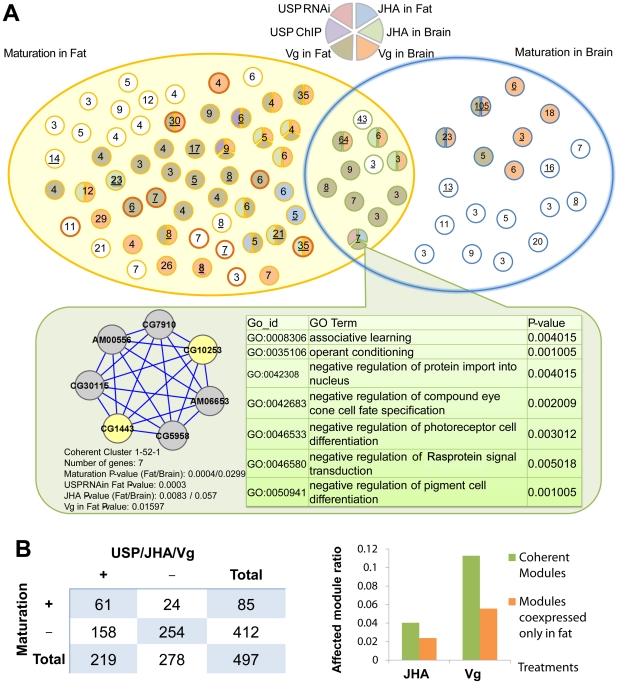
Transcriptional co-expression analysis reveals that maturation involves overlapping, hormonally regulated gene modules in the fat bodies and brain.A. CoherentCluster revealed 85 maturation-related “coherent” gene modules that were preserved between the fat bodies and brain (colored circles). These modules were enriched for genes that were differentially expressed between nurses in foragers in either the fat bodies, the brain, or both, as indicated by Venn Diagram categories. The number within each circle indicates the number of genes in the module; a bold outline indicates that the module contains at least one TF; underlined numbers indicate modules containing at least one usp-related gene (identified empirically by either RNAi or ChIP-chip experiments). Circles are colored based on their enrichment (P<0.05) for genes that are differentially expressed in response to usp RNAi, vg RNAi, or JHA. One module (f-15-2-1) is selected for demonstration (inset). Nodes in this inset represent individual genes, and edges indicate co-expression. Yellow nodes indicate genes that were responsive to (all three of) usp RNAi, vg RNAi, and JHA in the fat bodies. In addition, we show enriched Gene Ontology processes for genes within this module. B. Hormones regulate the expression of genes within many coherent modules. Left: contingency table for the number of coherent modules that were enriched for maturationally-regulated genes and for hormonally-regulated genes (USP targets, JHA-responsive genes, and Vg RNAi–responsive genes). Right: Proportion of coherent modules and of fat body-specific modules that were enriched for JHA-responsive genes and Vg RNAi-responsive genes.